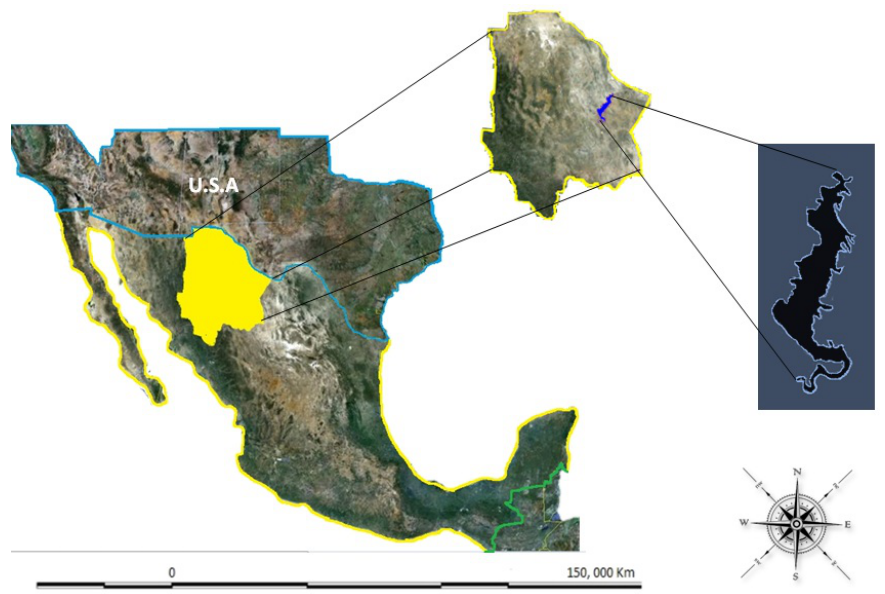
Figure 1. Location of the Luis L. Leon Dam in Chihuahua,